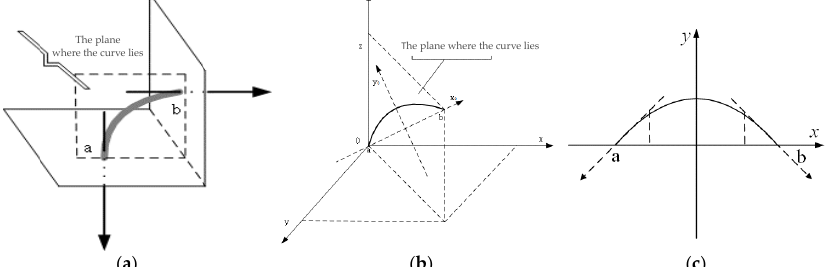
Figure 7. Hermite curve interpolation. ( a ) The plane defined by the cable starting point a , ending point b and the normals of the planes where they are located, ( b ) the Gaussian plane rectangular coordinate system based on the plane in the global three dimensional space coordinate system, and ( c ) the constructed Gaussian plane rectangular coordinate